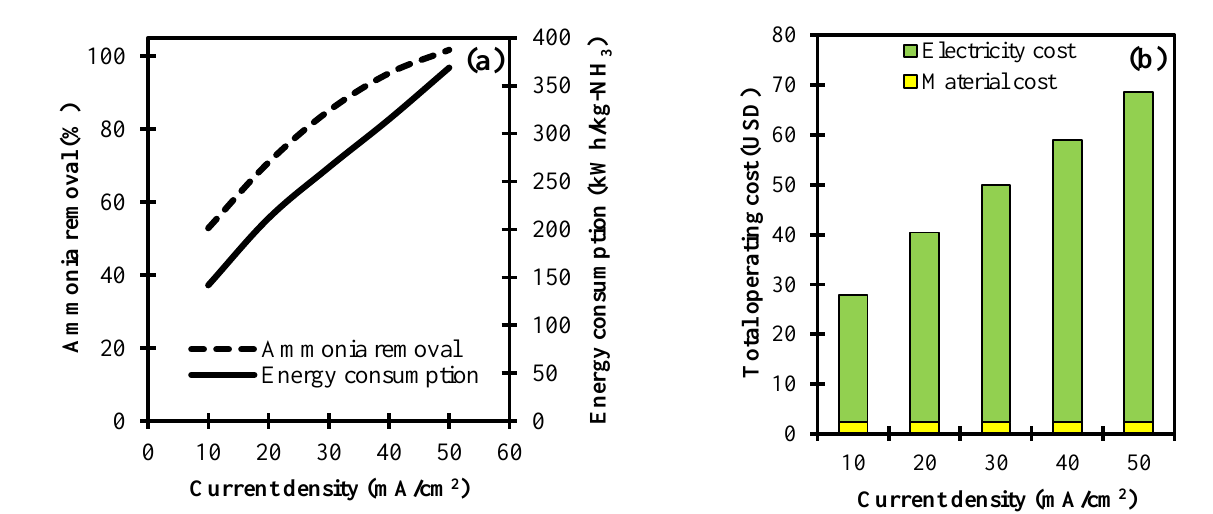
Figure 4. Process variable analyses of current density towards: ( a ) Ammonia removal, energy consumption, and ( b ) total operating cost in an electrochemical system.